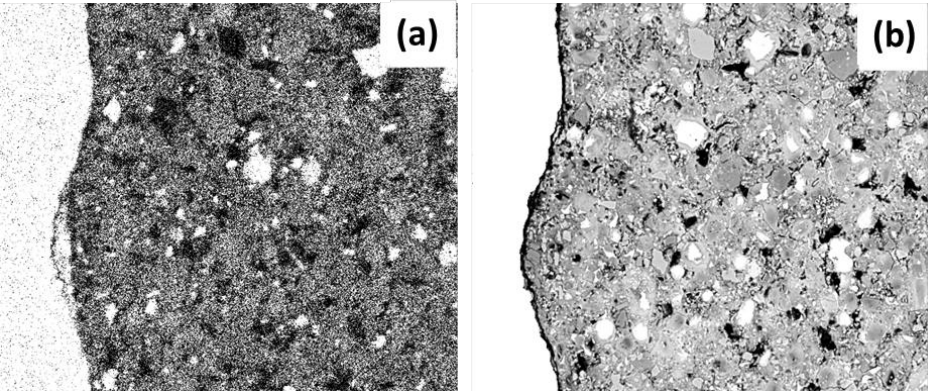
Figure 4. Preparation of the aggregate mask for the RCA 50 C sample ( a ) image after the operating instructions and ( b ) after the morphological